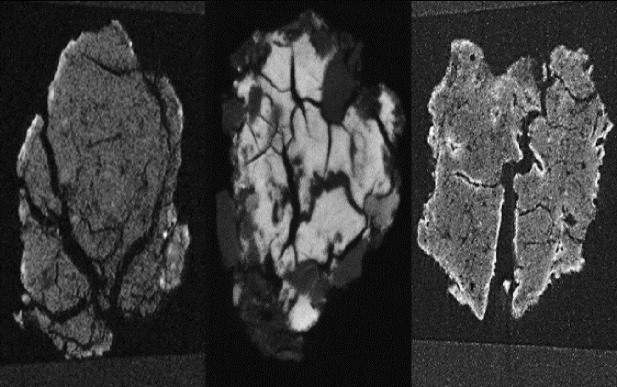
Images taken from post-blast aggregates displaying large cracks throughout the aggregate structures (left to right: a native soil aggregate following explosive charge detonation in contact with soil; a native soil aggregate following explosive charge detonation over soil; a landscape soil aggregate following explosive charge detonation over soil).Aggregate size 1–2 mm. Source: Holly Yu, Curtin University/University of Dundee.